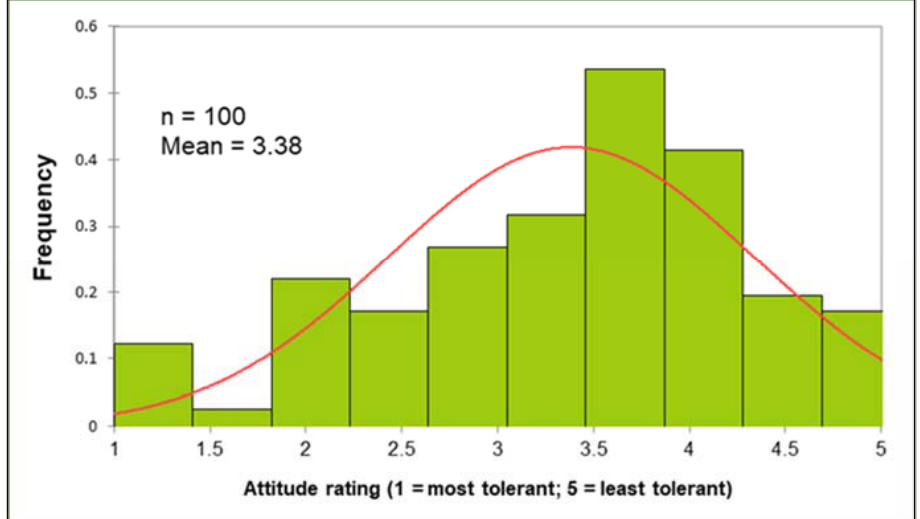
Figure 2. Attitudes among Cameroonian migrants in Switzerland.